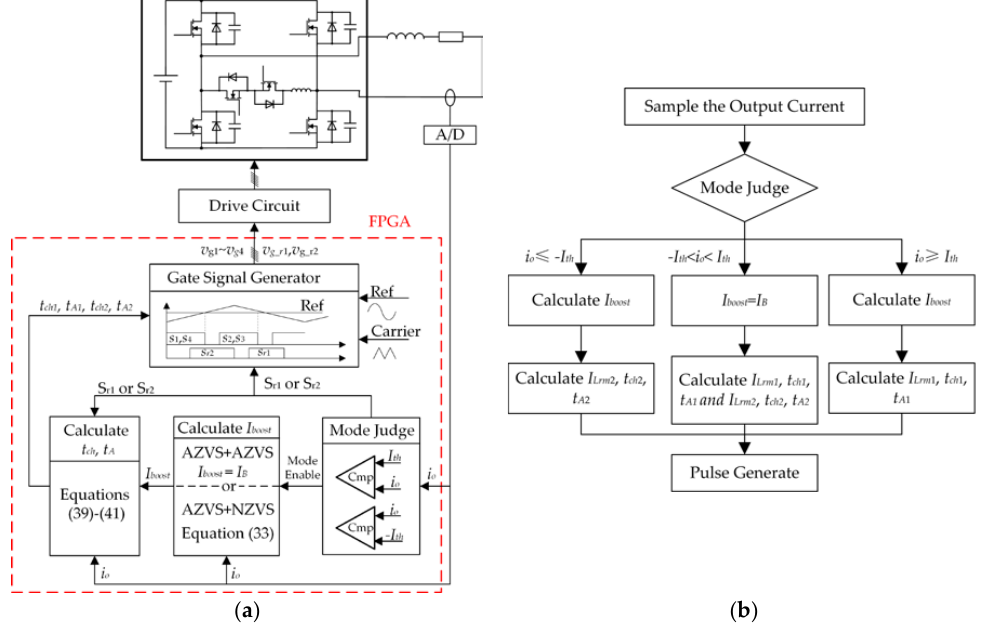
Figure 9. The open-loop realization diagram of the proposed control: ( a ) the control diagram and ( b ) the flowchart of the proposed control.